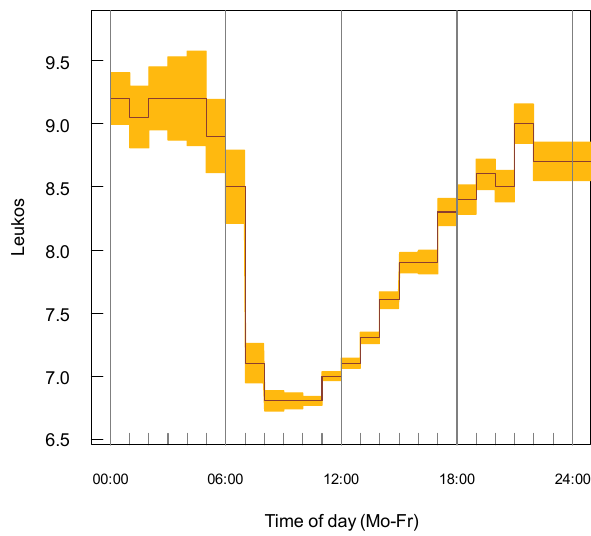
Figure 4: Diurnal variation of the leukocyte count in whole venous blood (ambulant patients, laboratory 2, n=39,256). Daily observations are calculated during one week and the medians from Monday to Friday are presented ( × 10 9 /L). The yellow areas represent the approximate 95% con fi dence limits based on the median absolute